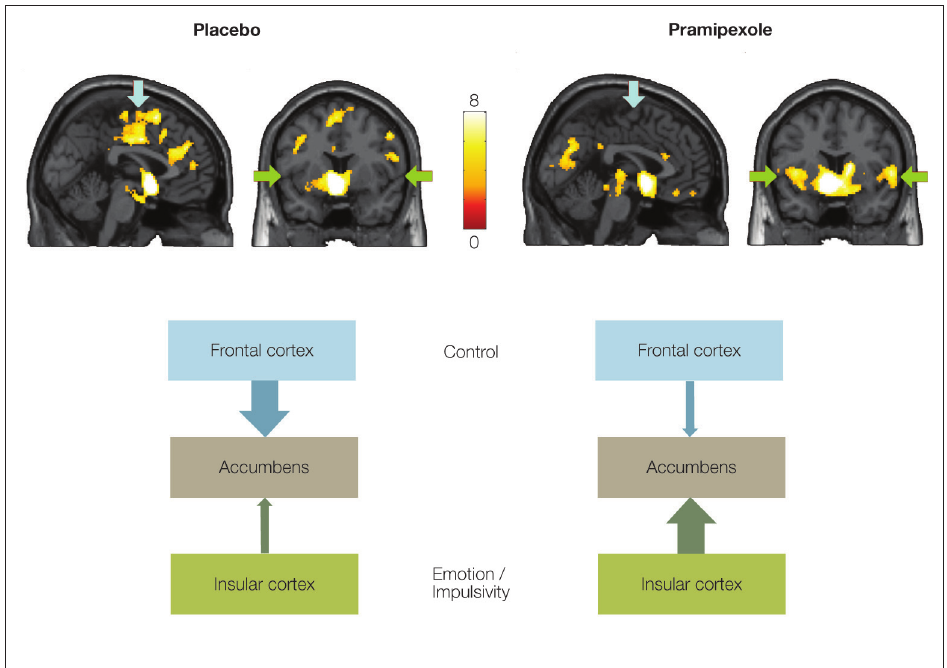
Figure 3 | Nucleus accumbens connectivity during reward expectation. Regions functionally connected with the NAcc during reward expectation under placebo and pramipexole. Arrows indicate the frontal cortex (blue) and the insular cortex (green). Left hemisphere is on the left side. Color scale refers to T values. Bottom: Scheme presents the connectivity patterns under placebo and